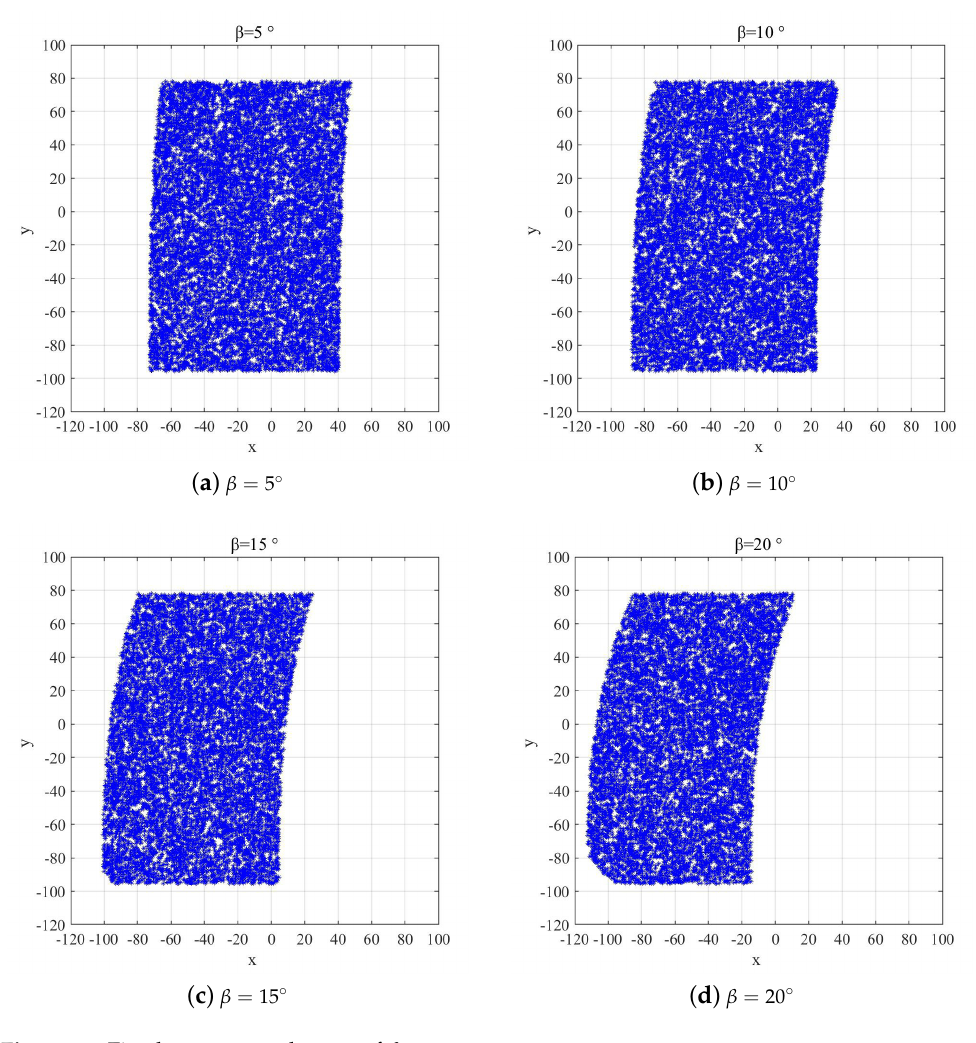
Figure 17. Fixed posture workspace of β .